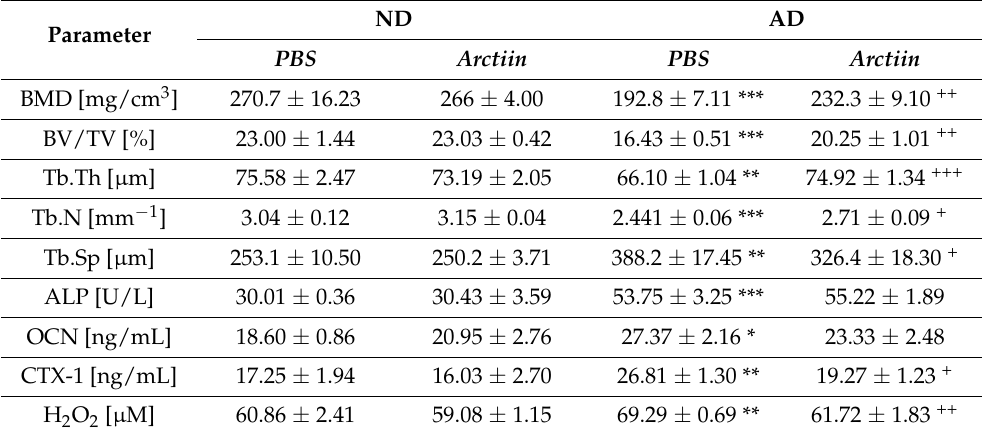
Table 1. Trabecular microarchitecture and biochemical markers of ND and AD-fed mice with or without arctiin treatment.